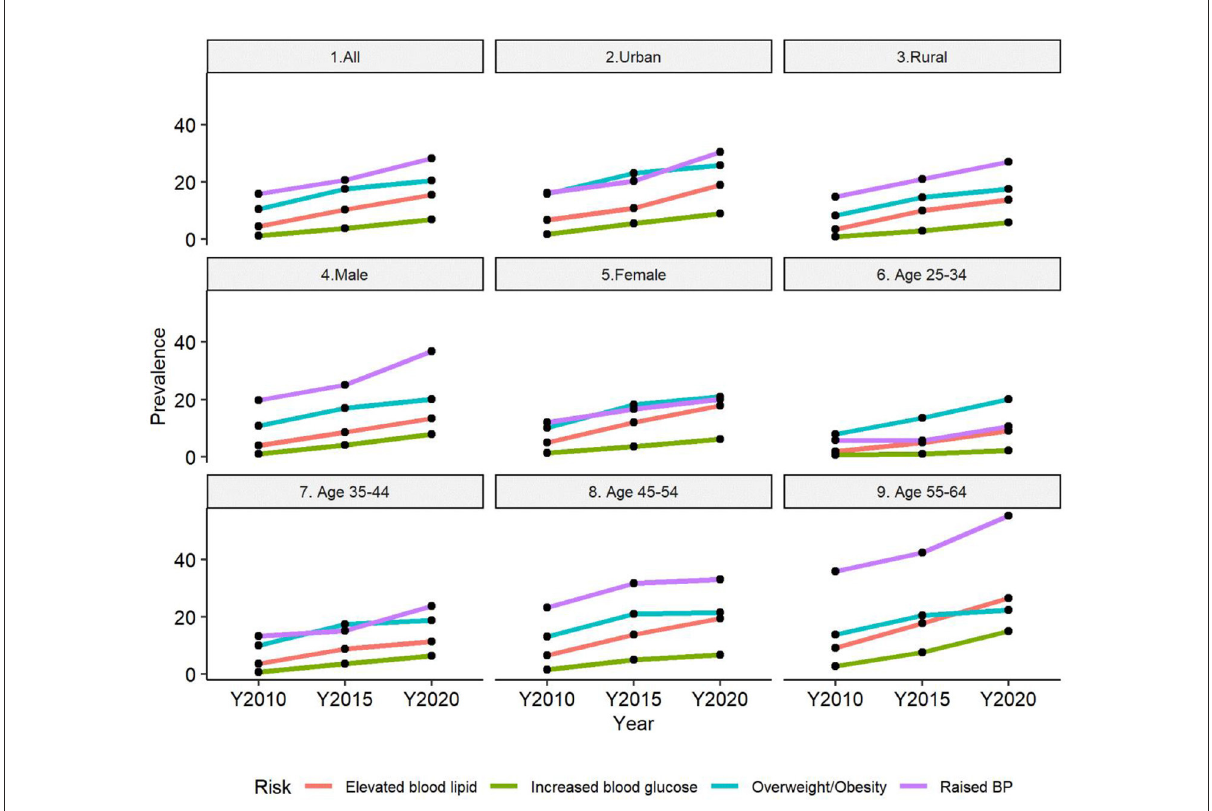
FIGURE5 Trends of NCD metabolic risk factors over time across different population